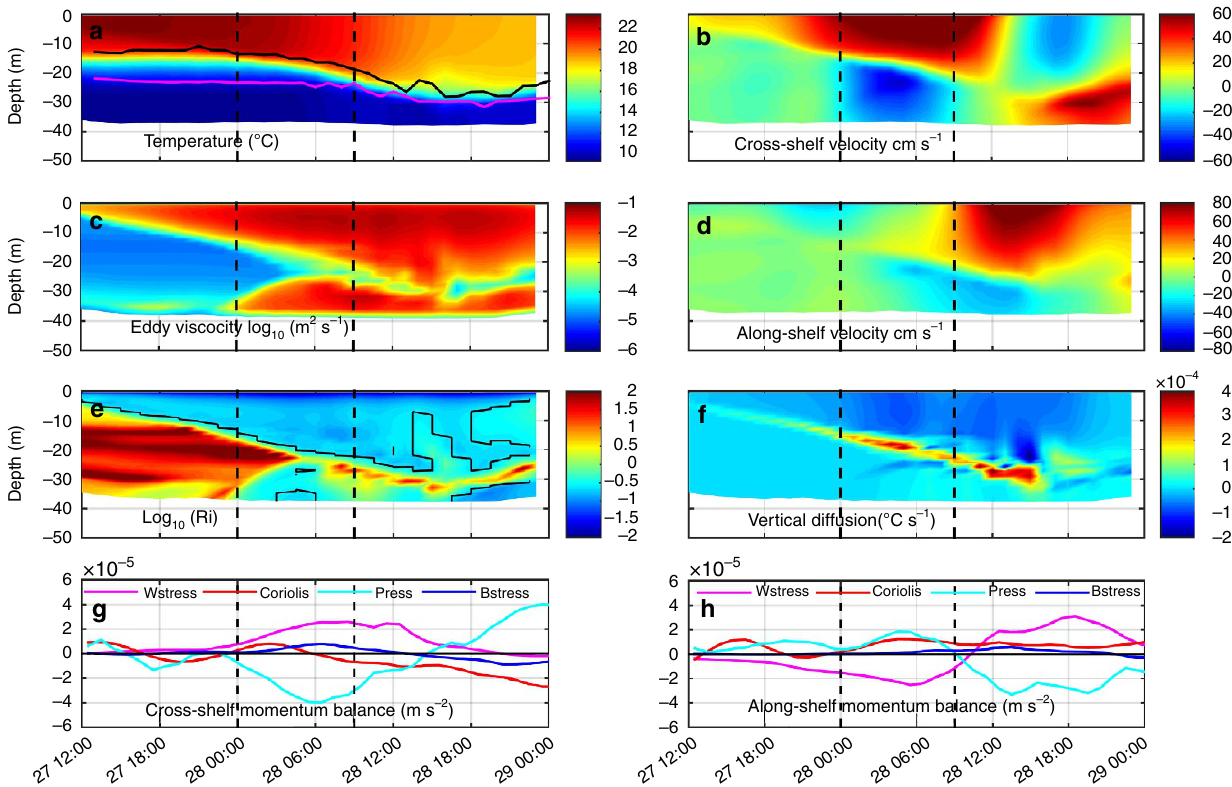
Figure 3 | ROMS ocean simulation results at the glider location. ROMS ocean simulation results at the glider location during the storm period, with first vertical black dashed line indicating initiation of the coastal baroclinic response and second vertical black dashed line indicating eye passage. ( a ) Temperature with top (black) and bottom (magenta) of thermocline as in Fig. 2b. ( b ) Cross-shelf velocity (red/yellow onshore; blue offshore). ( c ) Eddy viscosity. ( d ) Along-shelf velocity (red/yellow northward; blue southward). ( e ) Log 10 (Richardson number) with black contour indicating Richardson number of 0.25. ( f ) Vertical diffusion temperature diagnostic equation term, showing warming (positive, red/yellow) and cooling (negative, dark blue). ( g ) Dominant depth-averaged cross-shelf momentum balance terms (positive onshore and negative offshore) from wind stress (wstress, magenta), Coriolis force (coriolis, red), pressure gradient (press, cyan) and bottom stress (bstress, blue). ( h ) Same as g but for along-shelf momentum balance terms (positive northward, negative